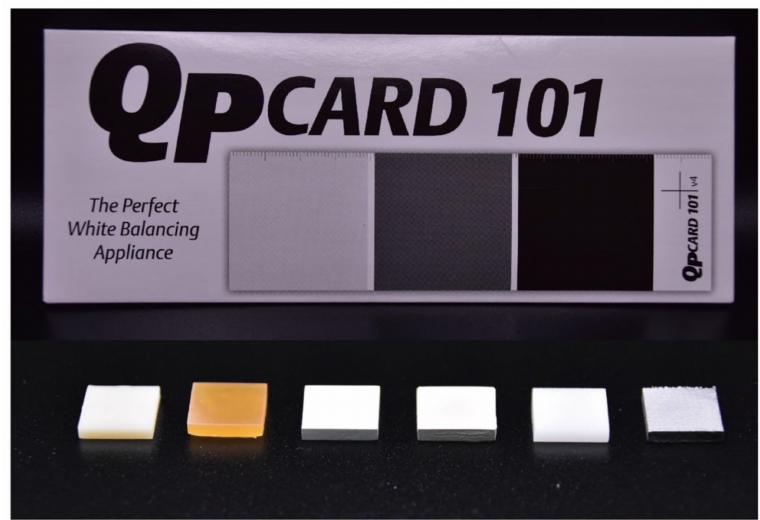
Figure 1. Substrate material. The upper row is the QP Card (white, gray, and black); the lower row shows CR, MR, PEEK, PEKK, Y-TZP, and Co–Cr in that order.